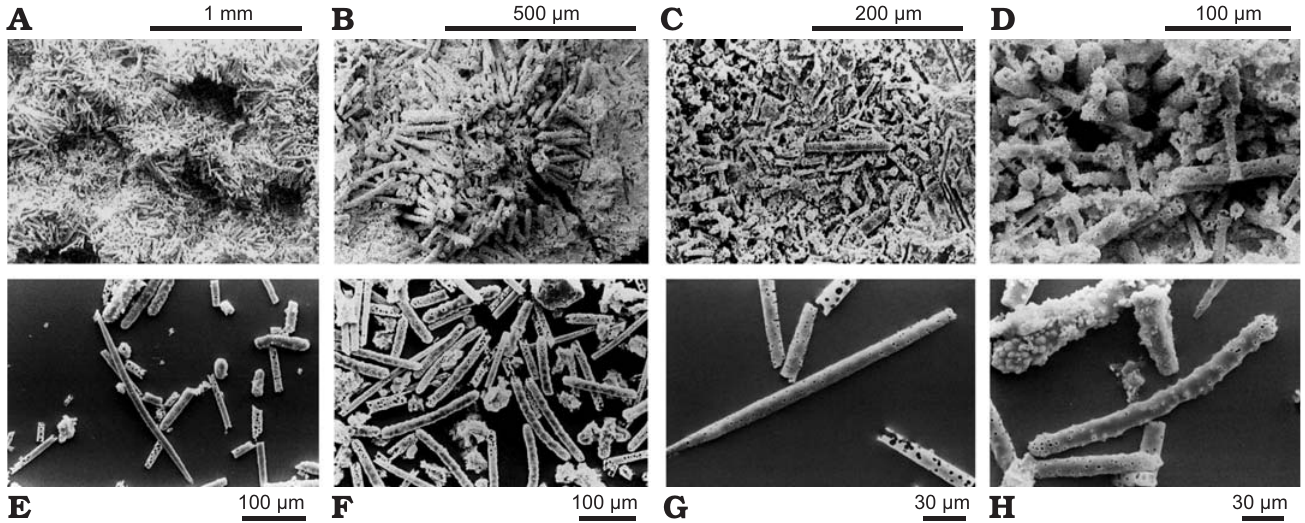
Fig. 14. Lutetiospongilla heili Richter and Wuttke, 1999, Spongillida: Spongillidae; Eocene, Messel oil shale, Germany. A . Holotype, SMF ME I 5143, carpet of closely bound gemmules with evident lumina and large radial gemmuloscleres. B . Single gemmular theca, firmly sessile on the surface of a woody plant, oblique view. Gemmular lumen (top right). C . Broken gemmule in the sediment with gemmular theca mainly formed of small more or less radially arranged gemmuloscleres. D . Broken-up lumen of a gemmule. Numerous mixed inner ends of large and small gemmuloscleres. E . Megasclere and large gemmuloscleres. F . Scattered sample with numerous huge gemmuloscleres. G . Megascleres originally finely spiny. Here, the pores are further apart and are narrower than in H. H . Gemmuloscleres from Messel with corrosion canals of original dense spines. SEM images. Modified from: A–D, Richter and Wuttke (1999); E, F, Richter and Baszio (2009); G, H, Richter and Baszio